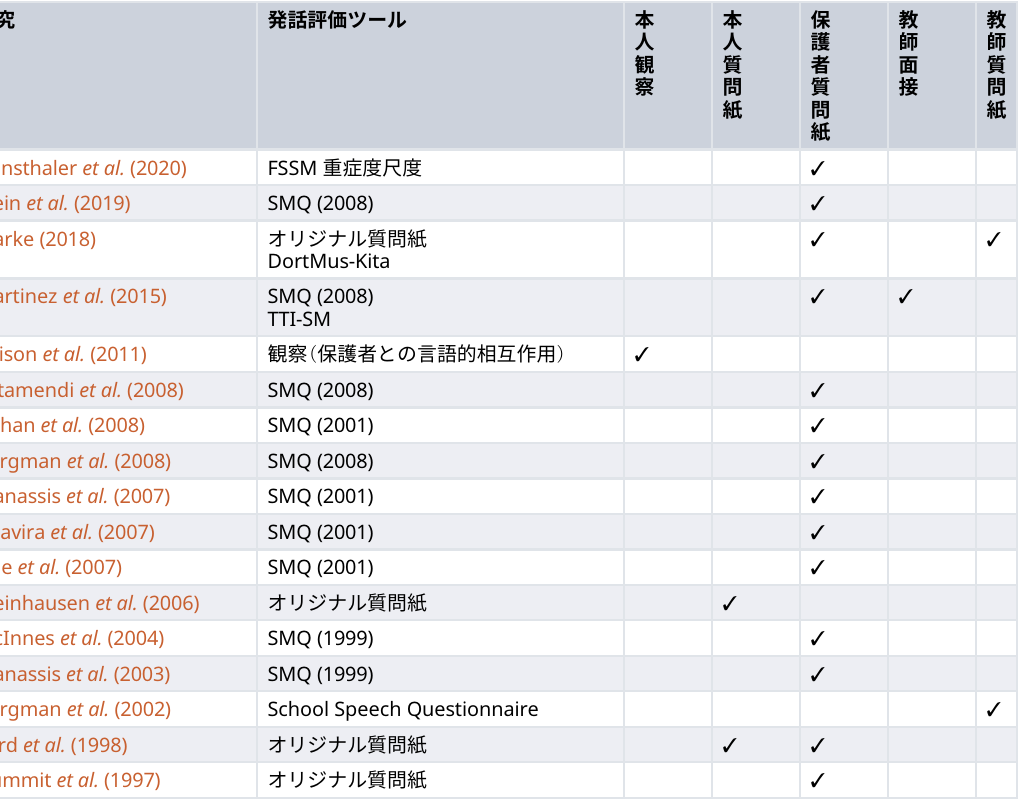
Table 3. 場 面 緘 黙 診 断 確 定 及 び 他 の 障 害 との 鑑 別 以 外 を 目的 とした 発 話評 価 の 手 法